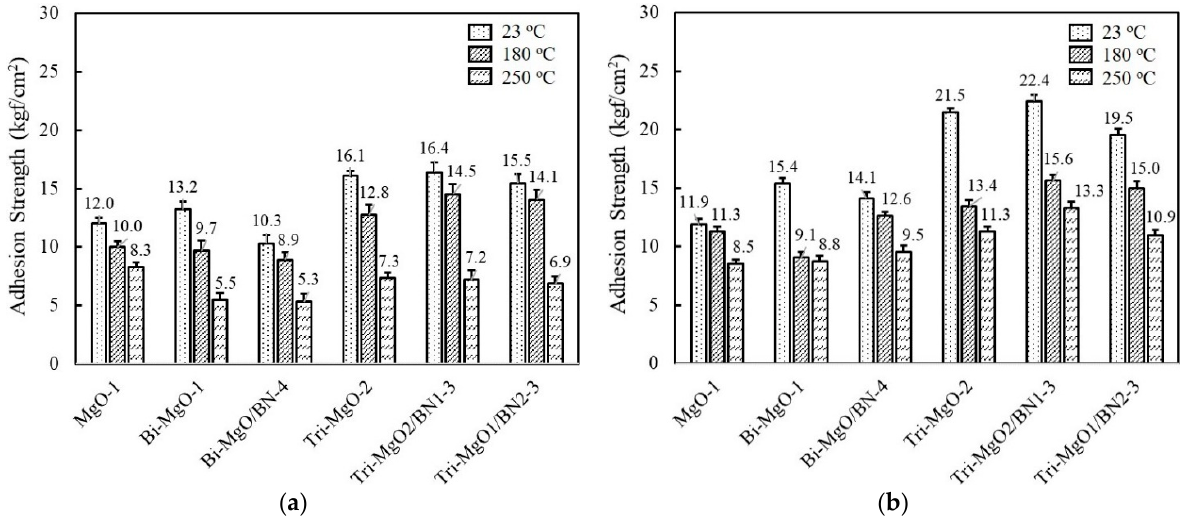
Figure 7. Comparison of the adhesion strength of unimodal, bimodal, and trimodal adhesives before and after aging at 85 °C/85% RH for 168 h: ( a ) Adhesion strength obtained before aging; ( b ) adhesion strength obtained after aging.